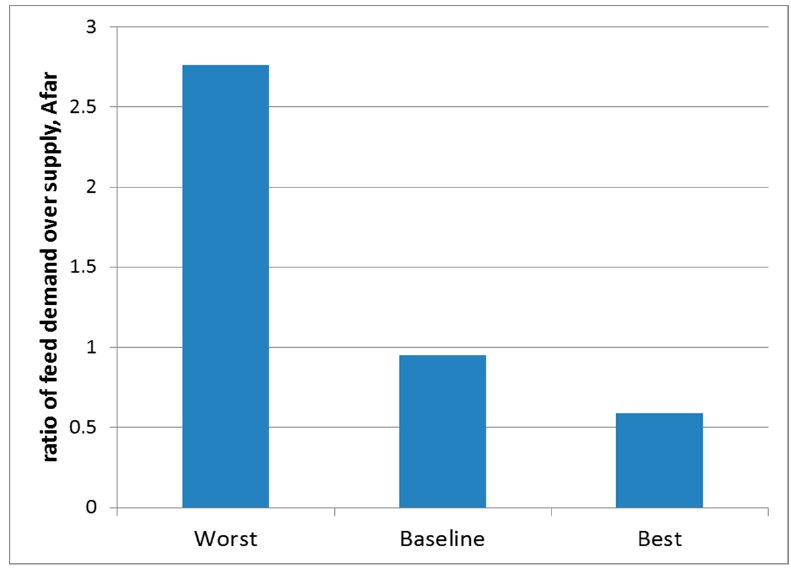
Figure 14. Ratio feed demand over supply for ’Worst, ‘Baseline’ and ‘Best’ scenario.